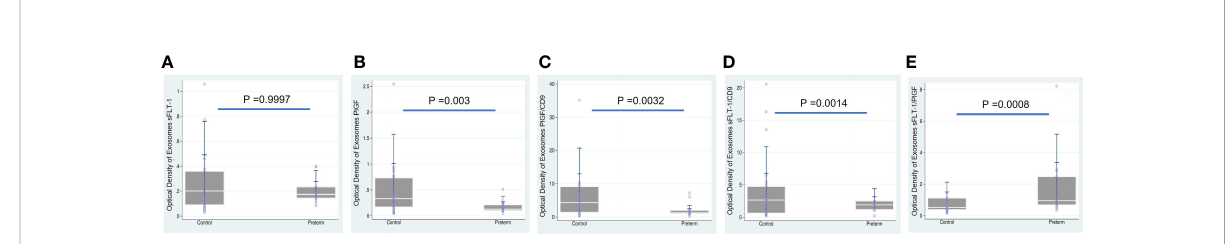
FIGURE 2 Boxplots overlaid with scatterplots showing median sFLT-1 and PlGF with/without normalization to CD9, and sFLT1/PlGF ratio, each in EVs-EXs, comparing preterm birth (PTB) and controls (Ctrl). (A) sFLT-1 in PTB (0.1733) vs. Ctrl (0.2001), (B) PlGF in PTB (0.1292) vs. Ctrl (0.3345), (C) PlGF/ CD9 in PTB (1.2857) vs. Ctrl (4.3520), (D) sFLT-1/CD9 in PTB (1.9224) vs. Ctrl (2.6671), and (E) sFLT-1/PlGF ratio in PTB (0.9578) vs. Ctrl (0.5226). As illustrated, sFLT-1 and PlGF are signi fi cantly lower in PTB (p<0.05), while the sFLT-1/PlGF ratio is signi fi cantly higher (p<0.05) in PTB compared to the Ctrl